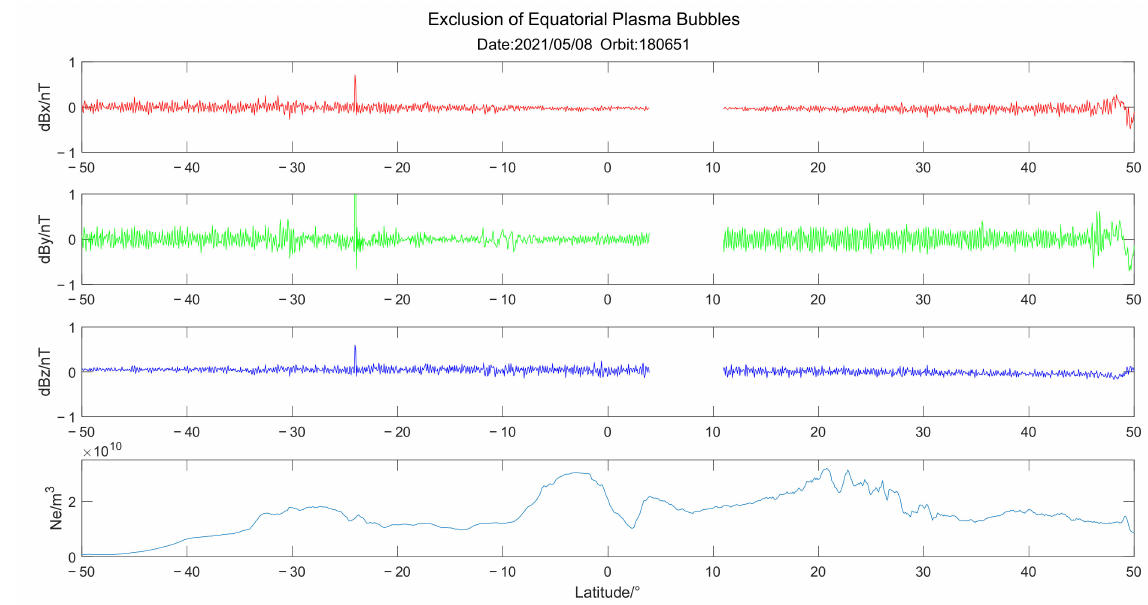
Figure 9. Exclusion of equatorial plasma